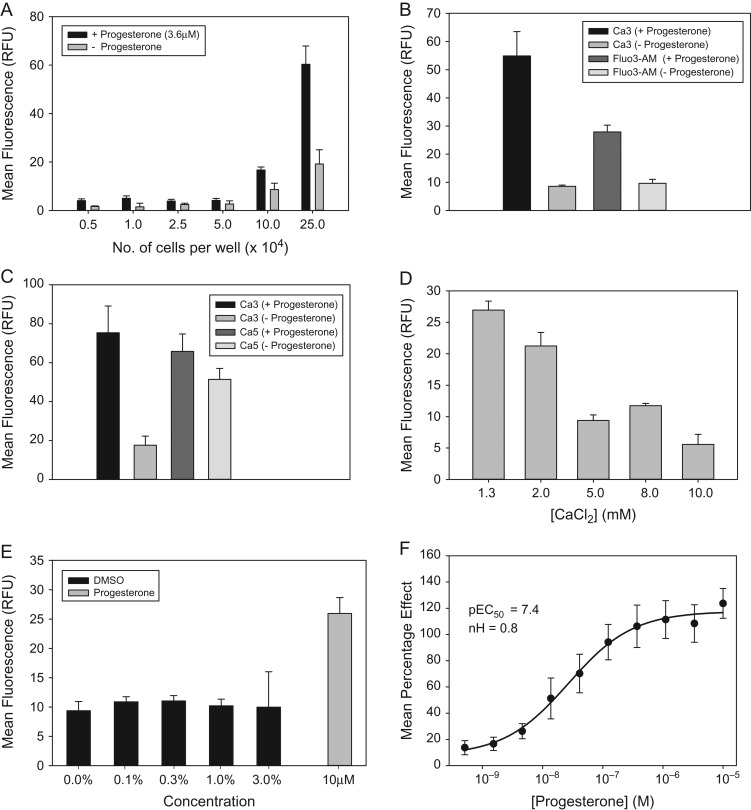
Flexstation assay development. Capacitated spermatozoa were pre-loaded with calcium-sensitive fluorescent dyes and progesterone evoked responses measured. Progesterone evoked fluorescence increased with increase in sperm cell concentration (A). Calcium 3 dye had a larger assay window compared with Fluo3-AM due to higher amplitude of fluorescence (B). Calcium 3 dye had a larger assay window compared with Calcium 5 dye, due to lower background fluorescence (C). Amplitude of the progesterone evoked response was inversely proportional to the extracellular calcium concentration (D). Progesterone elicited responses were unaffected by DMSO at concentrations up to 3% (v/v) (E). Progesterone evokes a concentration-dependent increase in intracellular calcium in human sperm cells (F).